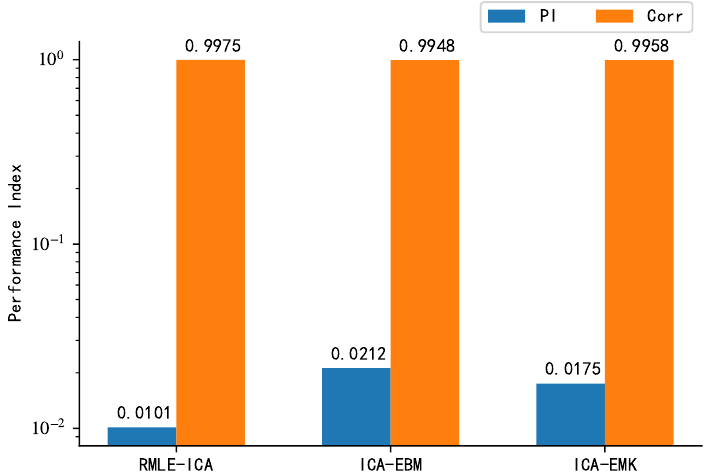
Figure 14. Performance comparison of proposed algorithm with ICA-EBM density function (PDF) and ICA-EMK density function (PDF) for sub-Gaussian distribution of source